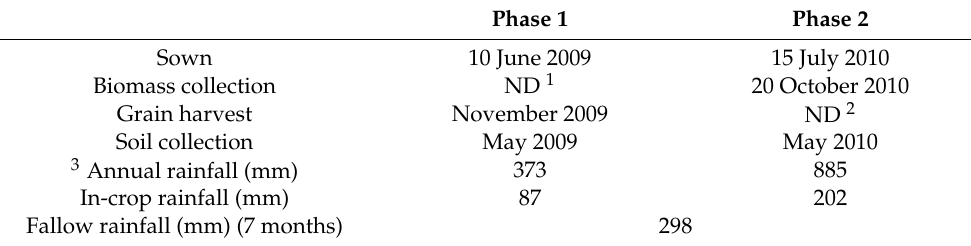
Table 3. The timing of operations and rainfall during Phase 1 and Phase 2 of the